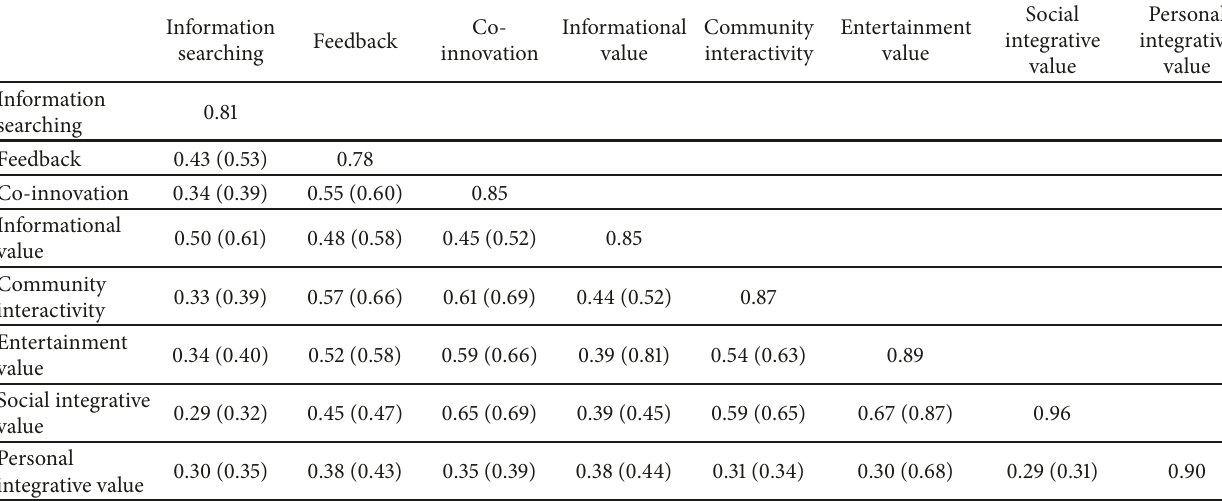
Table 3: Fornell-Larcker criterion (HTMT